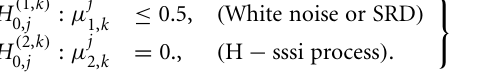
FIGURE 3 | From left to right: Group-averaged map-dependent MF parameters μ j and red curves code for j = R (Rest) and j = T